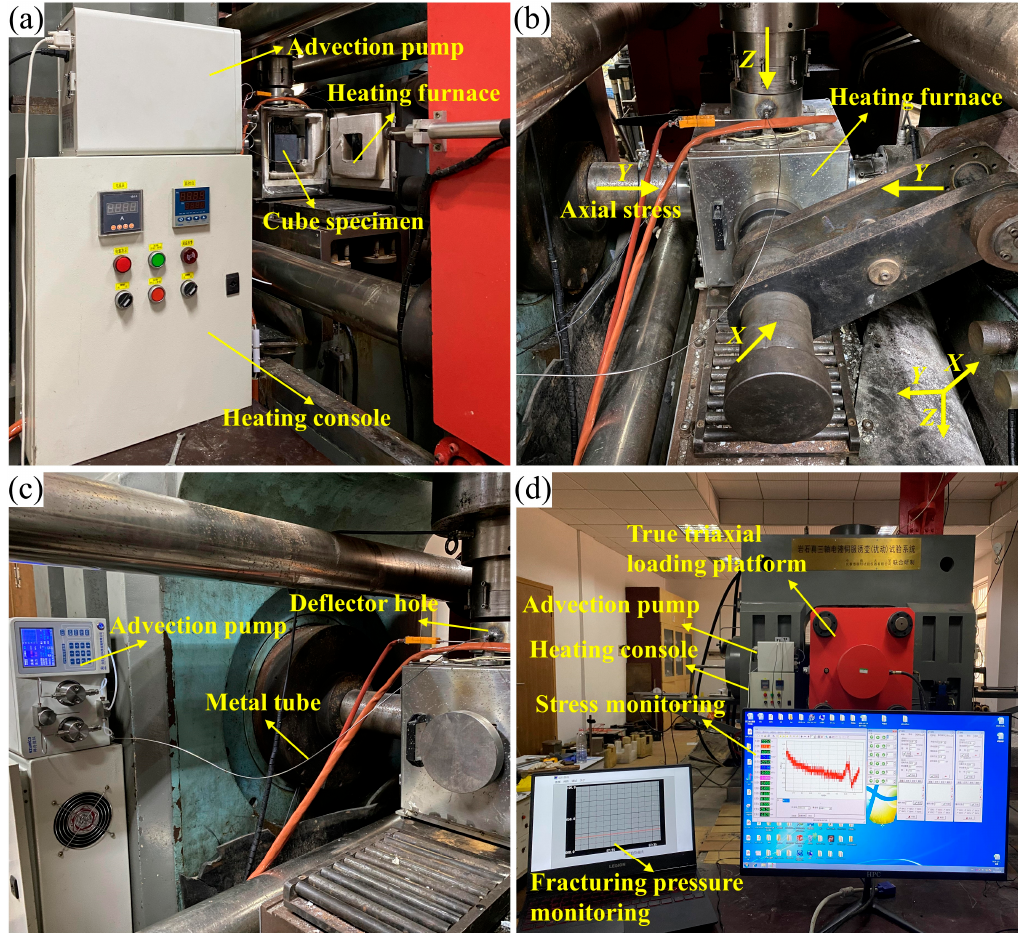
Figure 6. Real-time high temperature true-triaxial hydraulic fracturing platform: ( a ) the heating system; ( b ) the true triaxial loading system; ( c ) the water injection and sealing system; ( d ) the computer monitoring system.